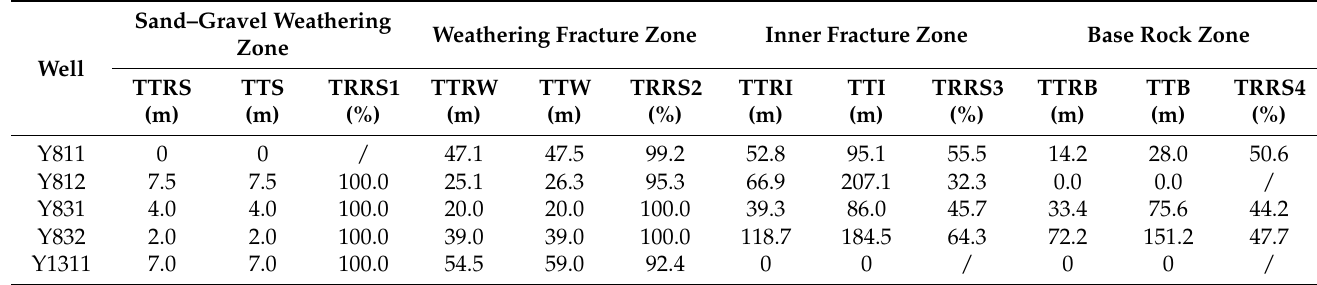
Table 2. Statistics table of the reservoir thickness, the strata thickness, and their ratio of intrusive rock buried-hill in the Y